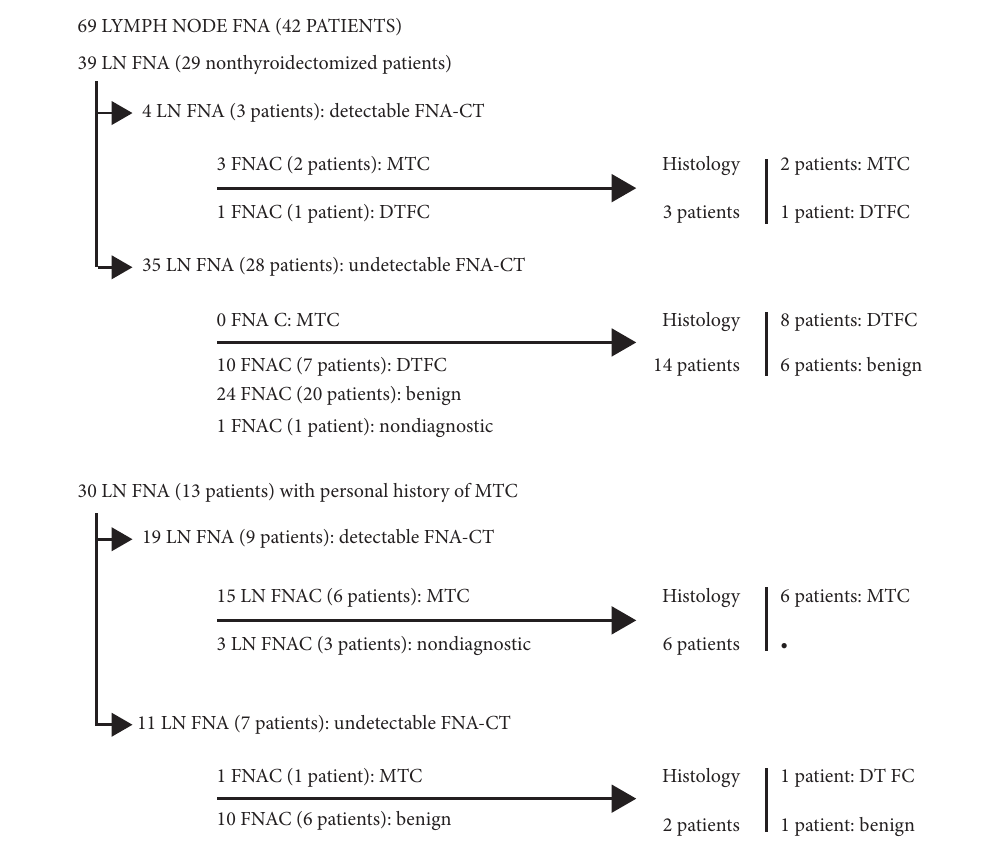
Figure 2: Histologic examination of LN, according to FNA-CT Table 3: Diagnostic accuracy of FNA cytology and FNA-CT.